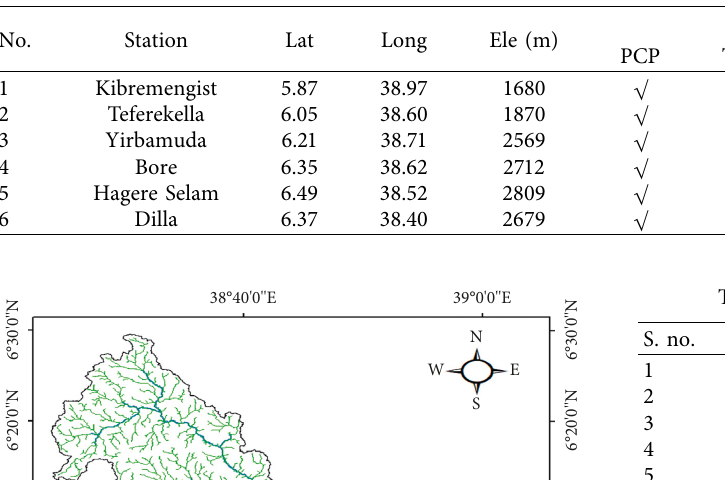
Table 1: Location of the weather stations and availability of weather data.